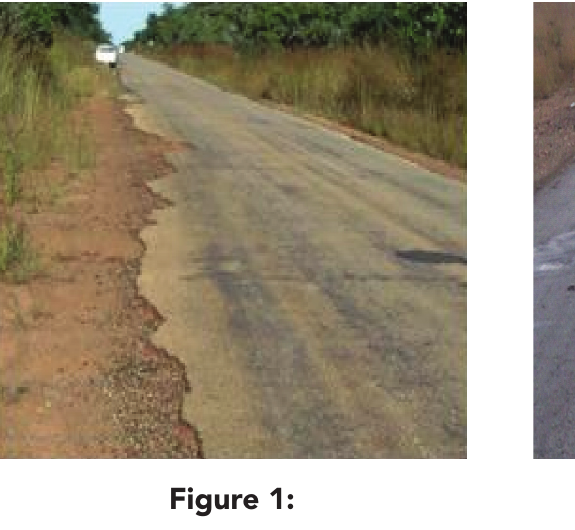
Fracturing along the edge Potholes on trunk road pavement (Source: Gumbie & Kudenga